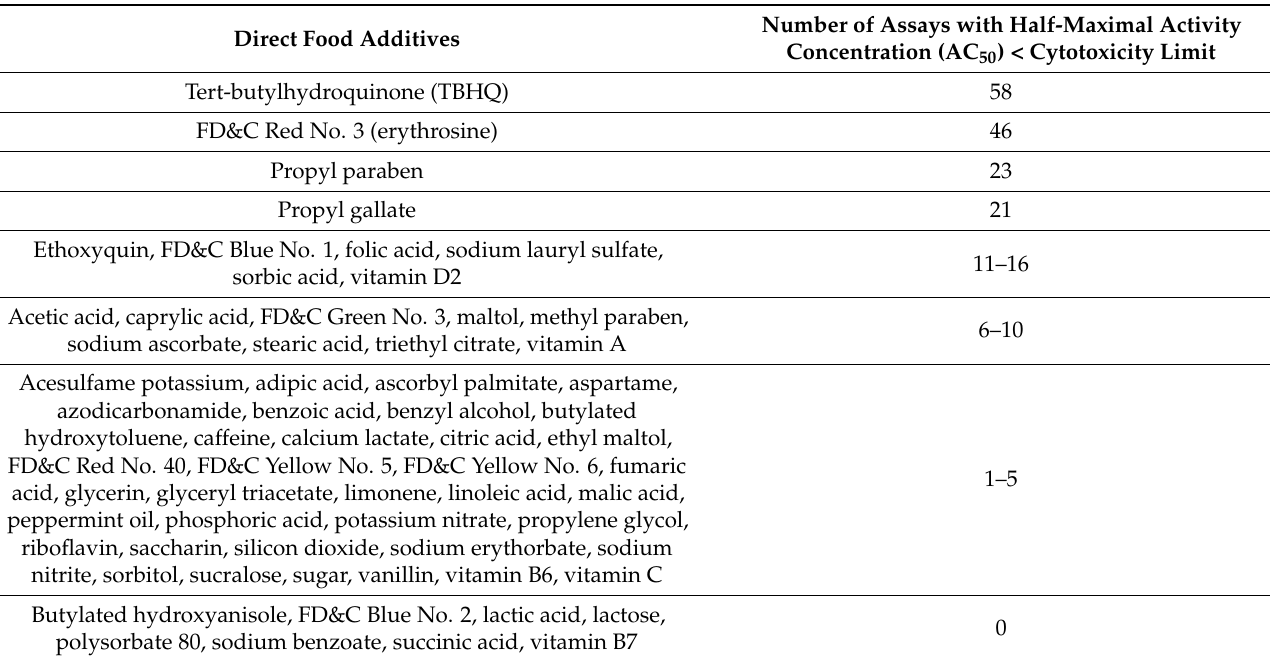
Table 2. Number of ToxCast assays for direct food additives with the half-maximal activity concentration (AC 50 ) below the cytotoxicity limit identified in Figure